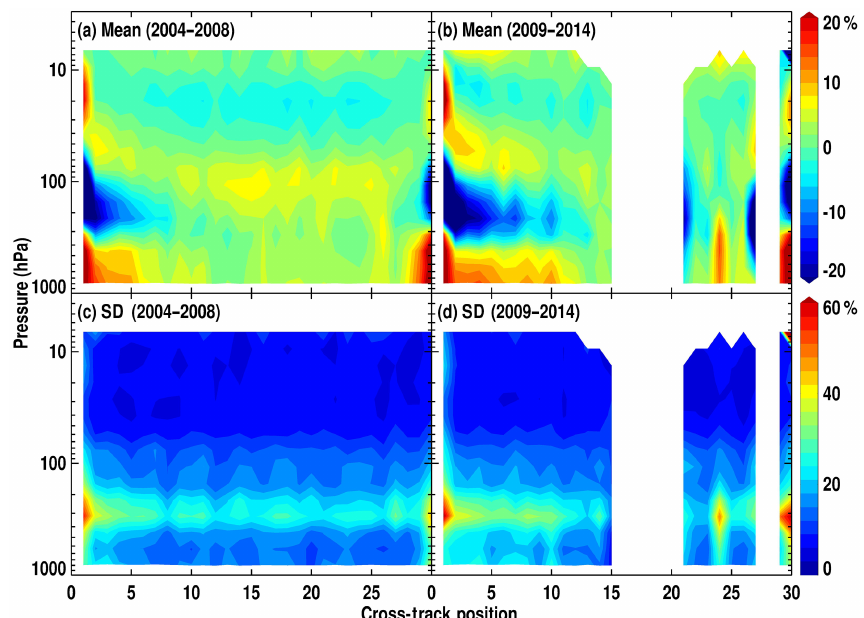
Figure 7. Same as Fig. 5 but as a function of cross-track position for (left) pre-RA (2004–2008) and (right) post-RA (2009–2014) periods.